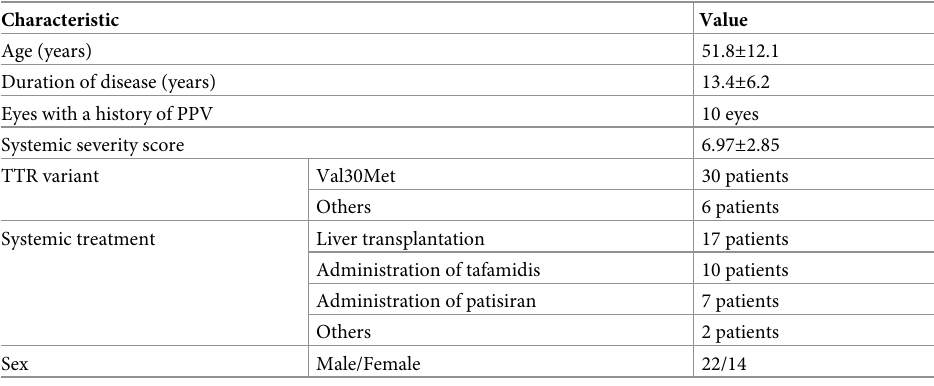
Table 1. Demographic and clinical characteristics of the 36 patients.